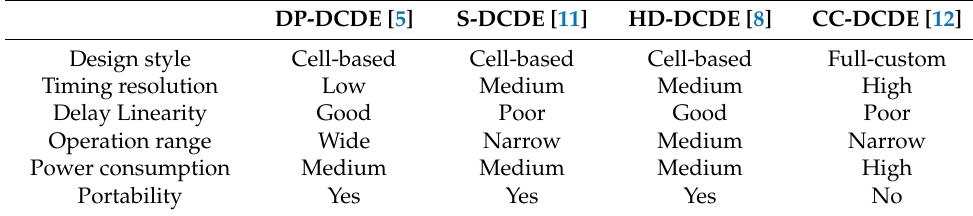
Table 1. Comparisons of different digitally controlled delay element (DCDE)